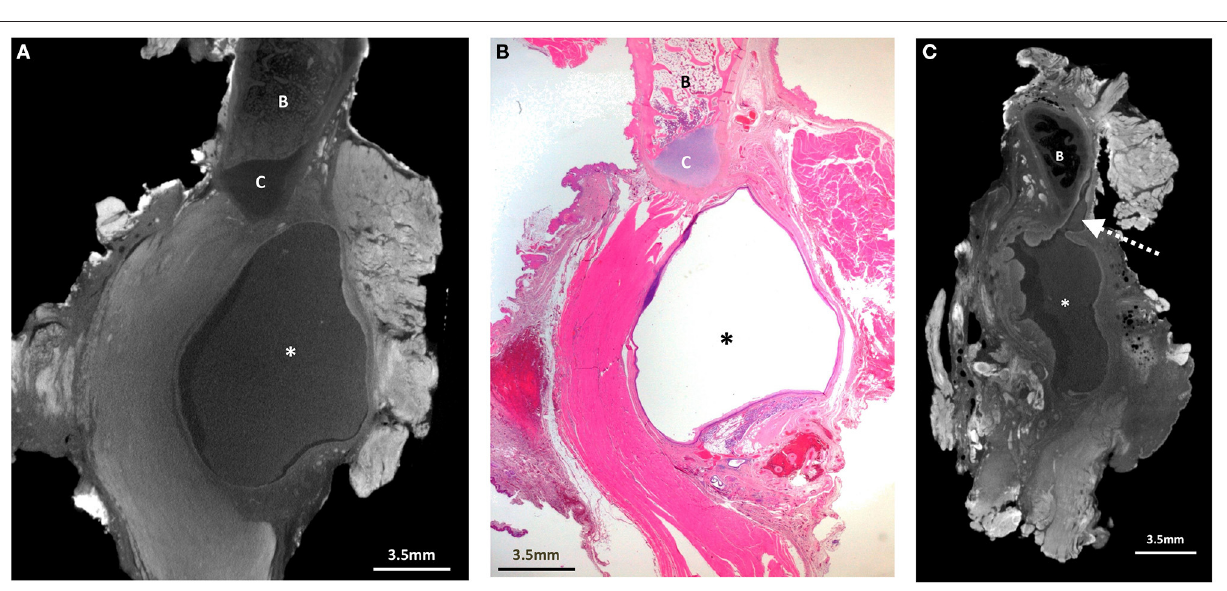
FIGURE 3 | Excised thyroglossal duct cyst specimen from a 6-year-old male patient (case 3). (A) Paired iodinated micro-CT imaging at 19.9 micron resolution, and (B) histopathological section with H&E staining in sagittal section demonstrate a well encapsulated thyroglossal duct cyst (*), just anterior to the hyoid cartilage (C). The hyoid bone is demonstrated by the “B.” Although the thyroglossal duct was not present in the histopathological section, it was possible from the 3D imaging dataset to reconstruct the (C) sagittal viewing plane for better duct visualisation (dashed